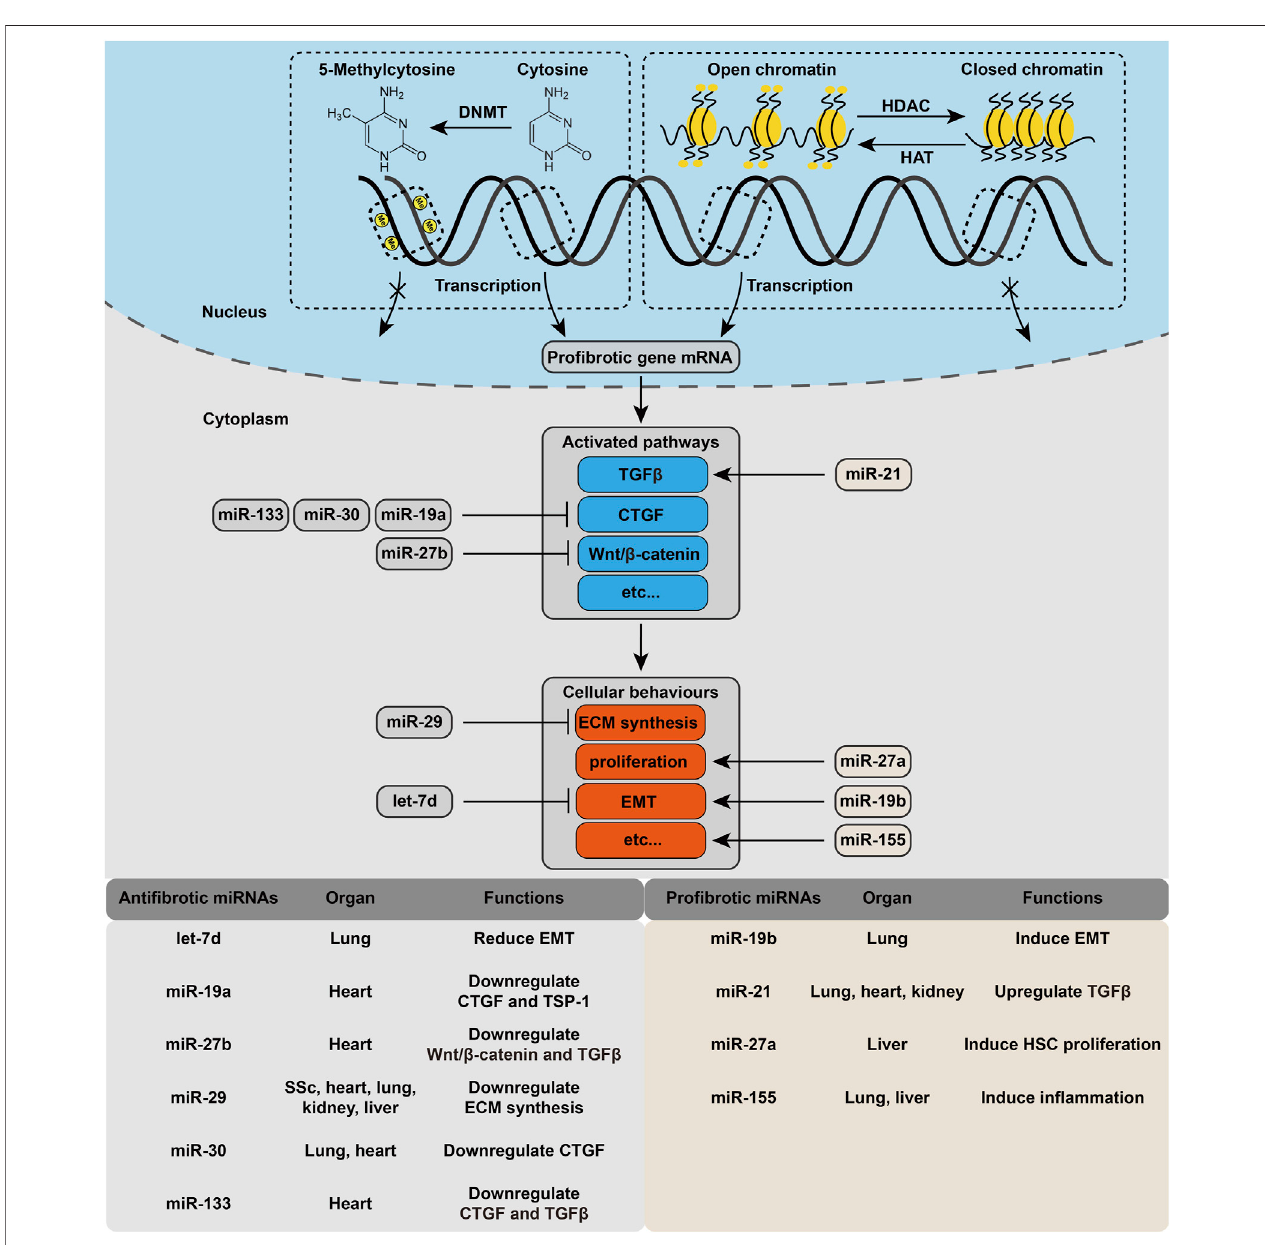
FIGURE 3 | Cellular mechanoeffecting mechanism in fi brosis. Each step of the activation of pro fi brotic pathway is under regulation of different kind of epigenetic modi fi cation. Several mechanosensitive miRNAs are also involved in this process.